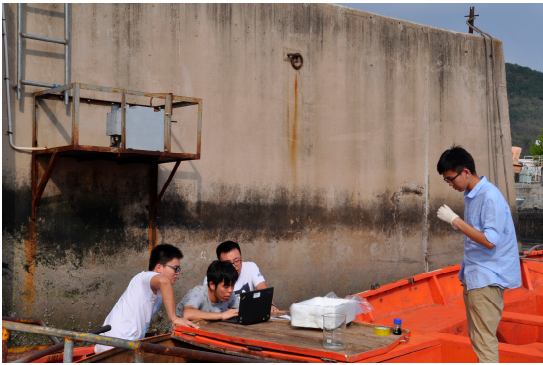
Figure 9. Observation site used for the simulated oil spill experiment.